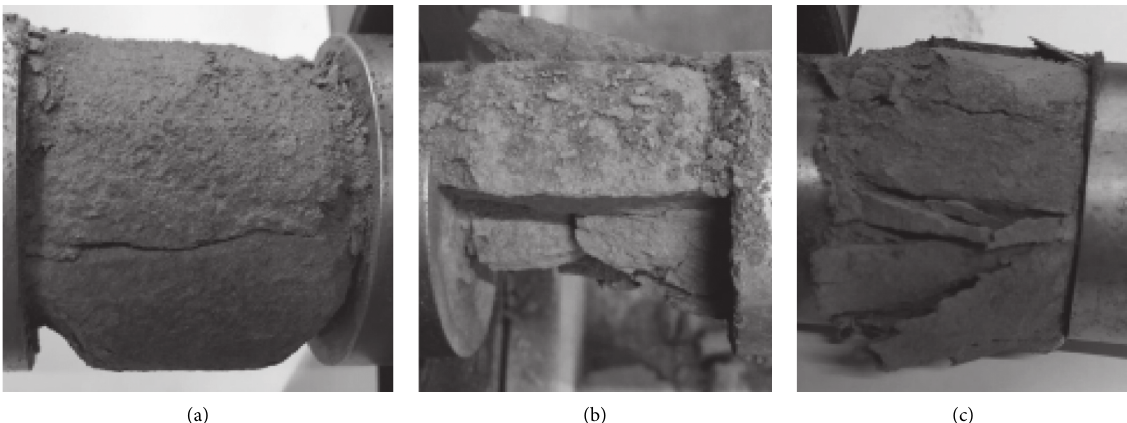
Figure 11: Failure modes of rock samples under 10 cycles of freeze-thaw, axial pressures of 5MPa, and different emission pressures. (a) 0.07 MPa, (b) 0.1MPa, and (c) 0.14 MPa.